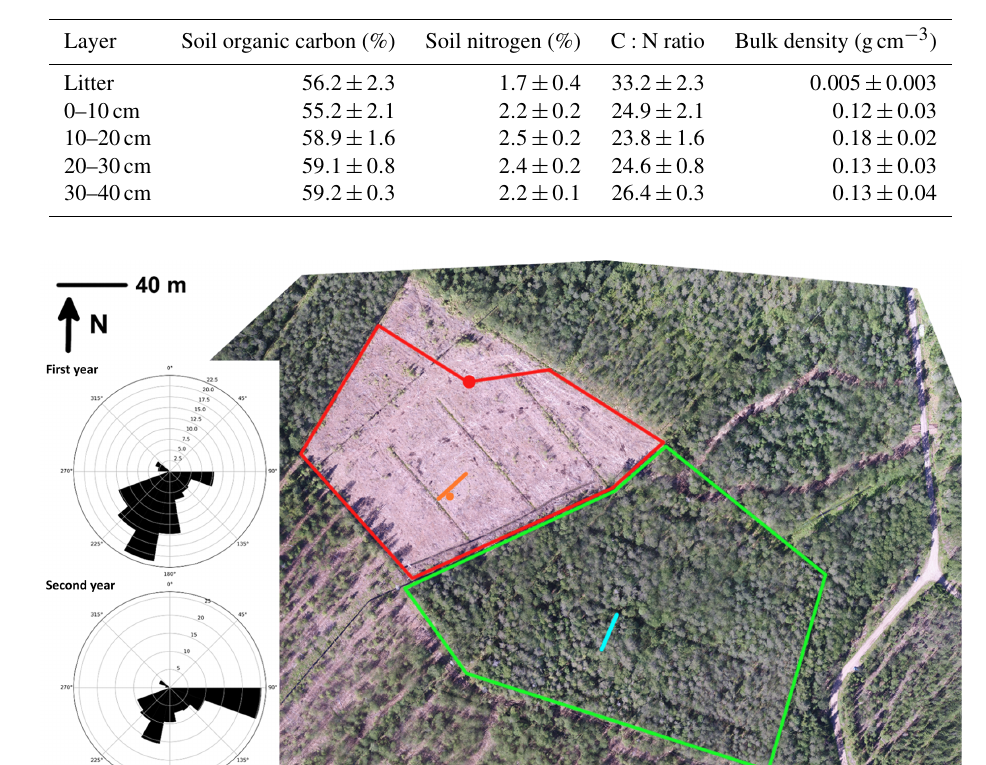
Table 1. Mean soil organic carbon, nitrogen, C : N ratio, bulk density and their standard deviation in different soil layers determined before the harvest ( n = 3–33).